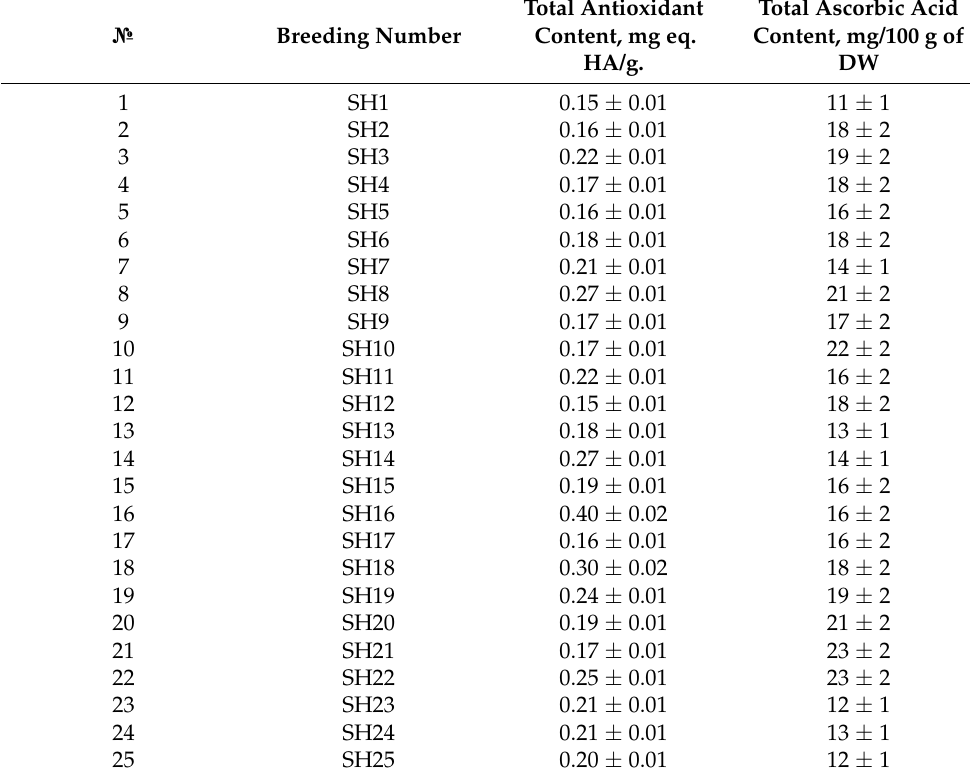
Table 5. Total ascorbic acid content and total antioxidants